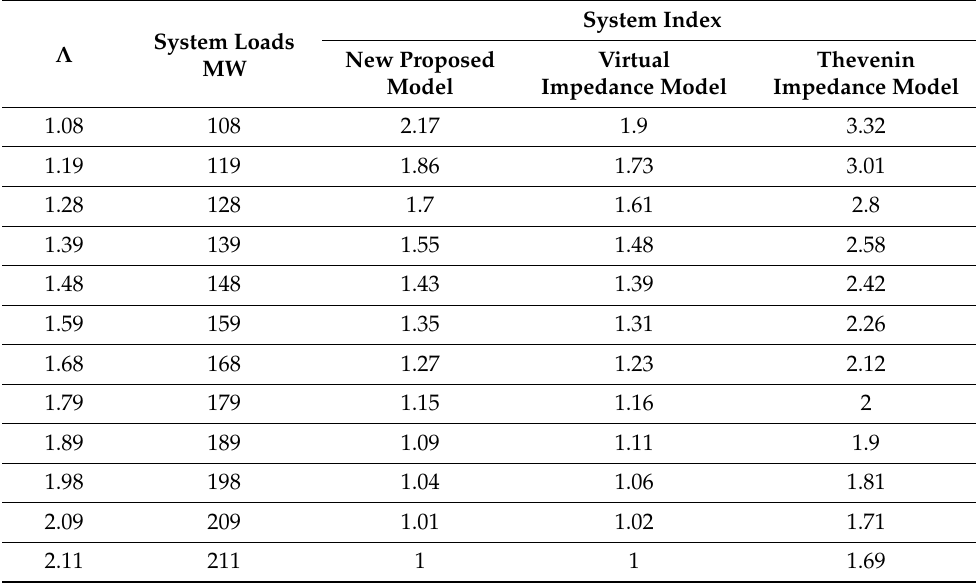
Table 3. Voltage stability system indices for the radial five-bus network with G 2 and l 24 out of operation when all loads increase.